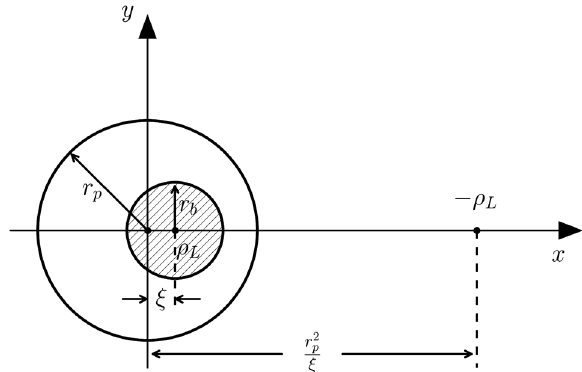
FIG. 5. Cross-sectional view of beam off-centered by ξ along the x-axis. A mirror line charge of − ρ Adapted from [[18] p